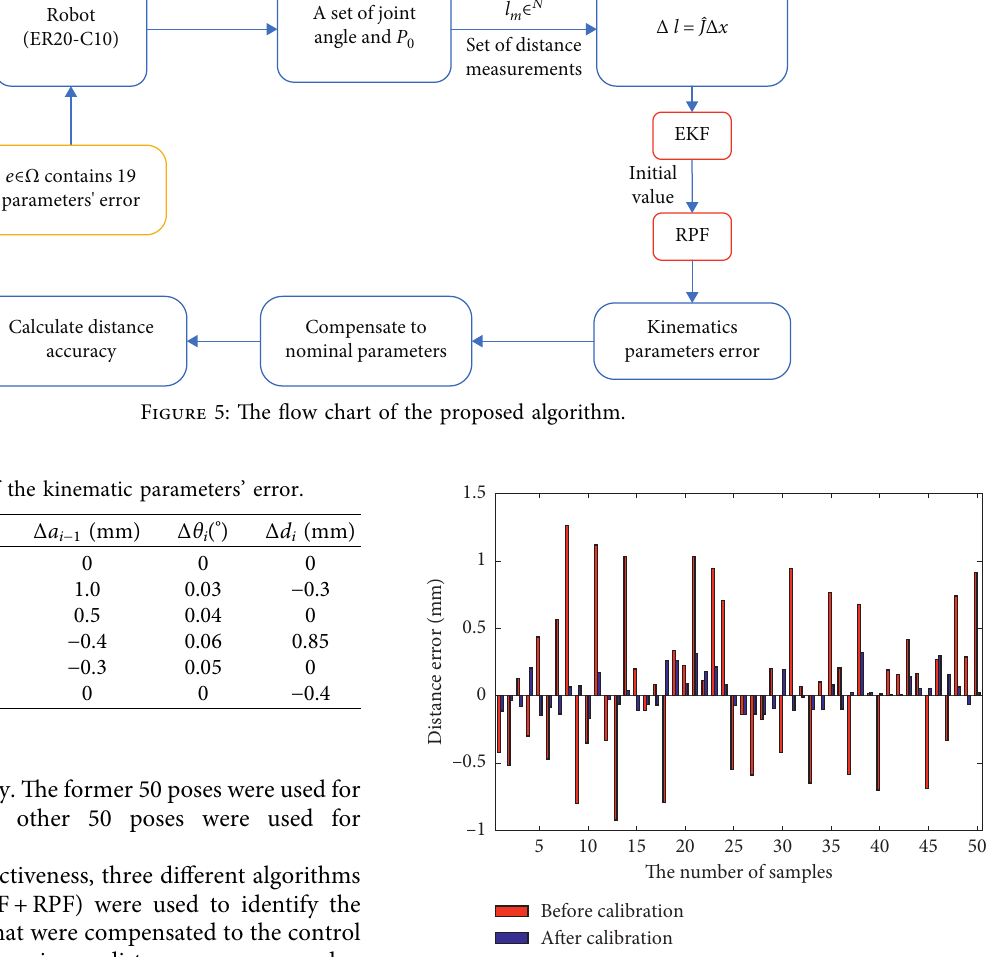
Figure 6: The distance error of the robot after compensation by